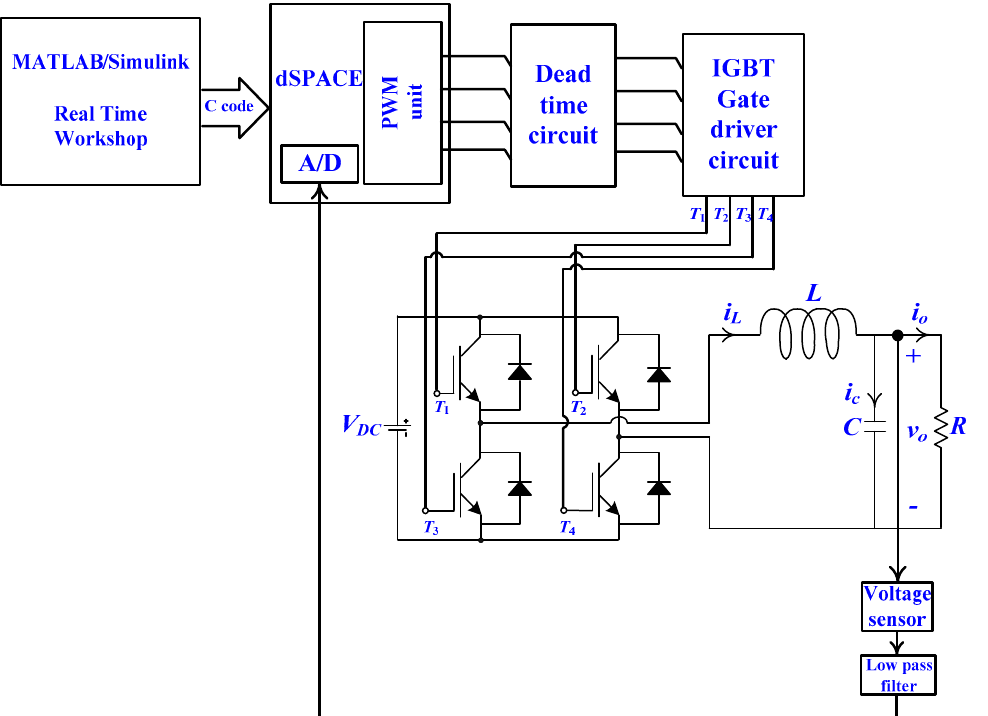
Figure 1. A control structure of an alternating current (AC) power supply system. PWM—pulse width modulation; IGBT—insulated gate bipolar transistor.